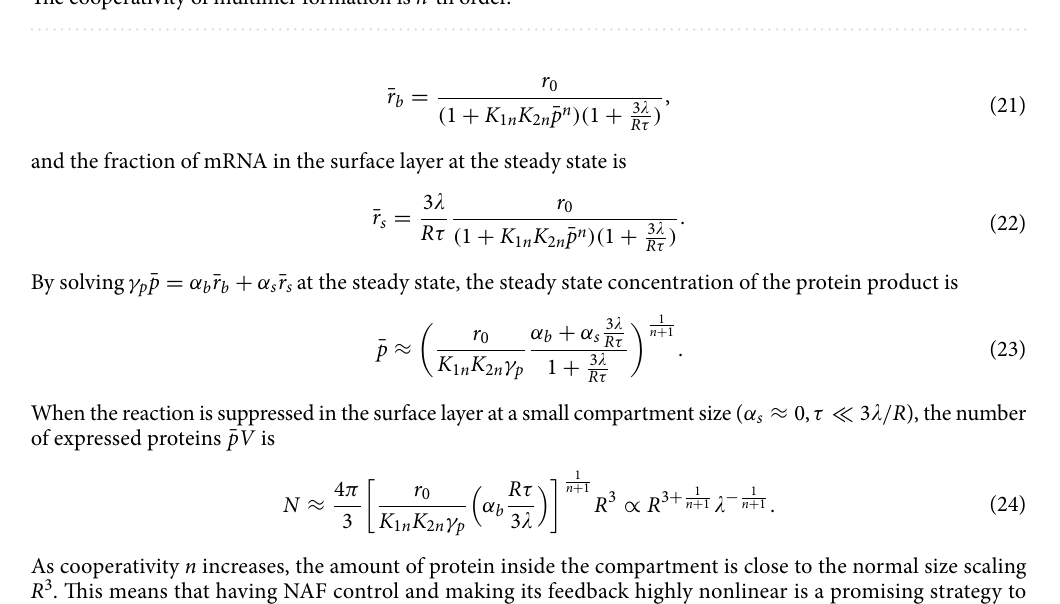
Figure 5. Confinement dependence of the TXTL reaction with autoregulatory feedback controls. The size dependence of the amount of expressed protein N in the compartment is shown for small and large radial size R . The cooperativity of multimer formation is n -th